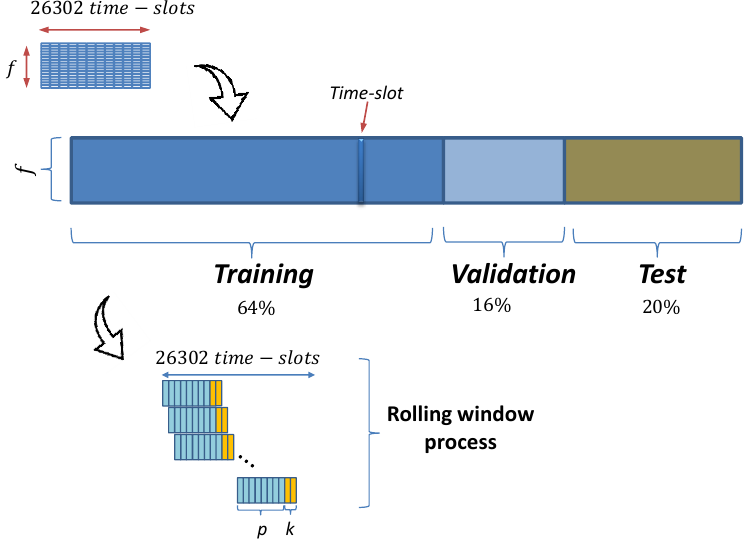
Figure 2. Division of the original dataset into training, validation, and test sets with a data proportion of 64, 16, and 20%, respectively. A rolling window process was used to extract the predictors sequence ( p time-slots used as predictors) and the real time-ahead load values ( k time-ahead forecast length). Each time-slot is represented by a vector of predictors with f components (load value, date/time features, etc.).